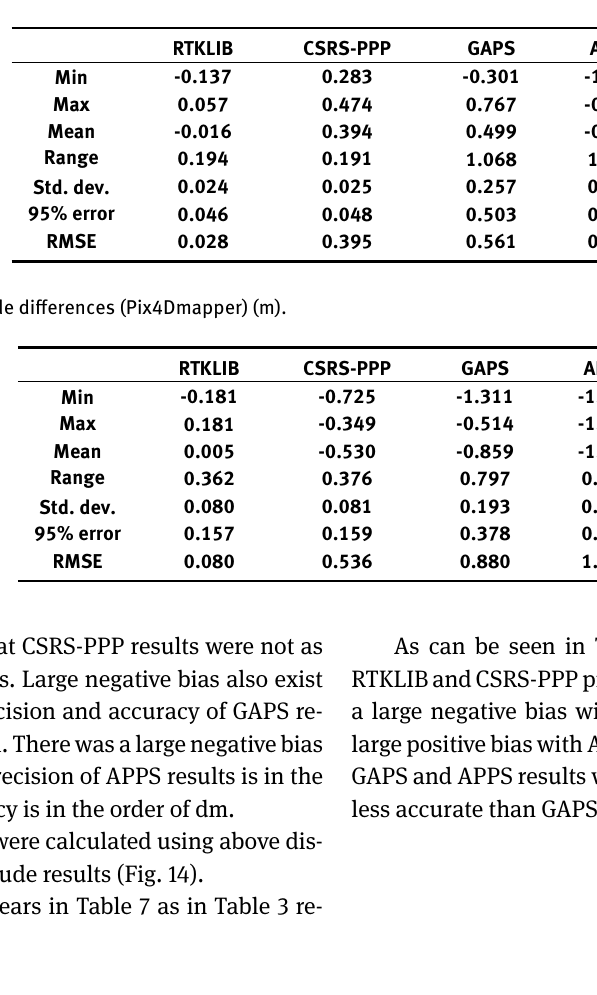
Table 5. Results about latitude differences (Pix4Dmapper) (m).